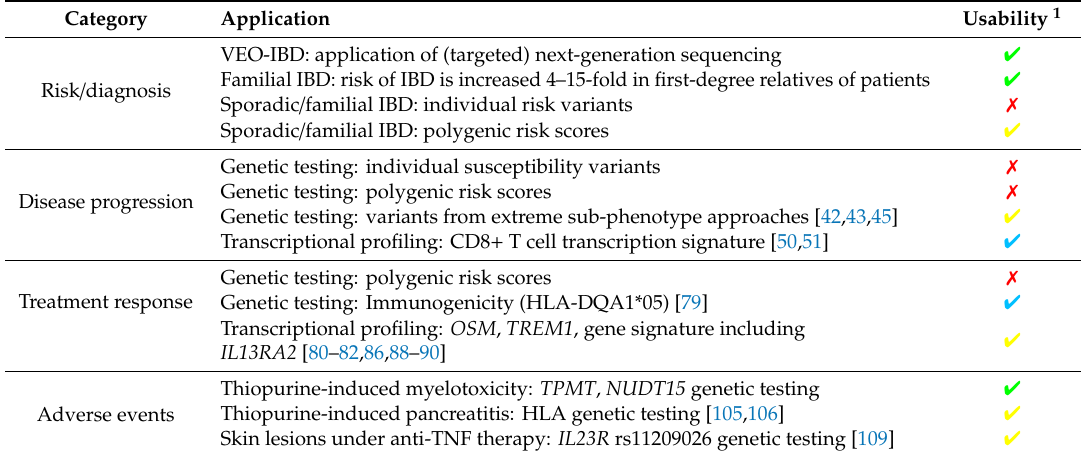
Figure 3. Schematic diagram of the currently most promising use of molecular profiling in inflammatory bowel disease. Some further details can be found in Table 2. VEO-IBD: very early onset IBD. Table 2. Current status of the prediction of several aspects of inflammatory bowel disease based on molecular